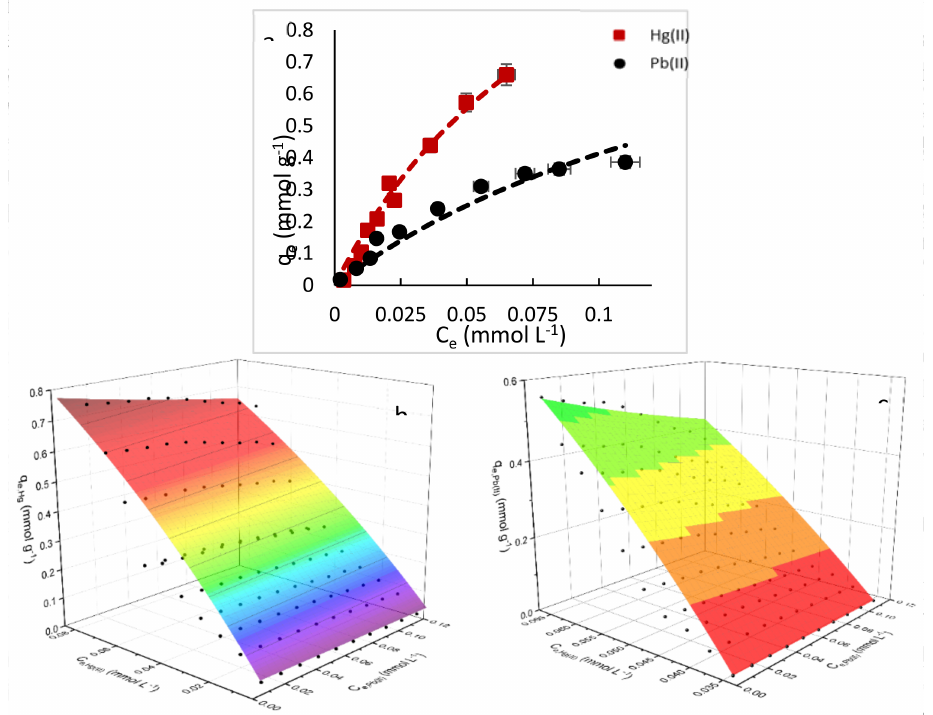
Figure 6. ( a ) Binary component sorption isotherms, ( b ) 3D surface for Hg(II) sorption capacity response vs. Hg(II) and Pb(II) interactions, and ( c ) 3D surface for Pb(II) sorption capacity response vs. Hg(II) and Pb(II) interactions. ( T : 20 ◦ C; sorbent dosage: 1 g · L − 1 ; agitation speed: 180 rpm; contact time: 48 h, pH o = 4.5, C o = 0.15 mmol · L − 1